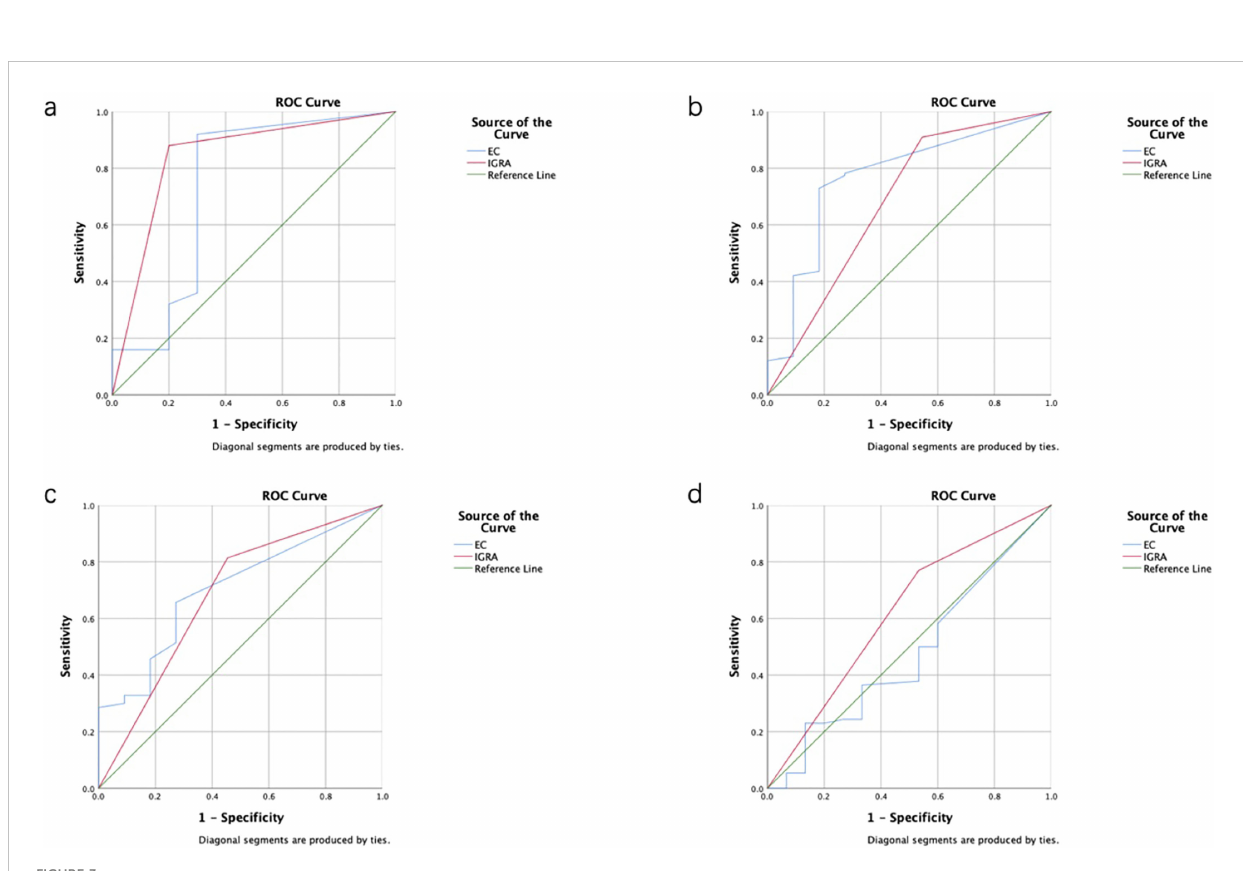
FIGURE 3 Receiver operating characteristic (ROC) curves of the ECST and IGRA tests in patients of different ages. (A) ROC curves for EC skin and IGRA tests in patients aged 0 – 18 years. (B) ROC curves for EC skin and IGRA tests in patients aged 19 – 52 years. (C) ROC curves for EC skin and IGRA tests in patients aged 52 – 65 years. (D) ROC curves for EC skin and IGRA tests in patients aged 65 – 94